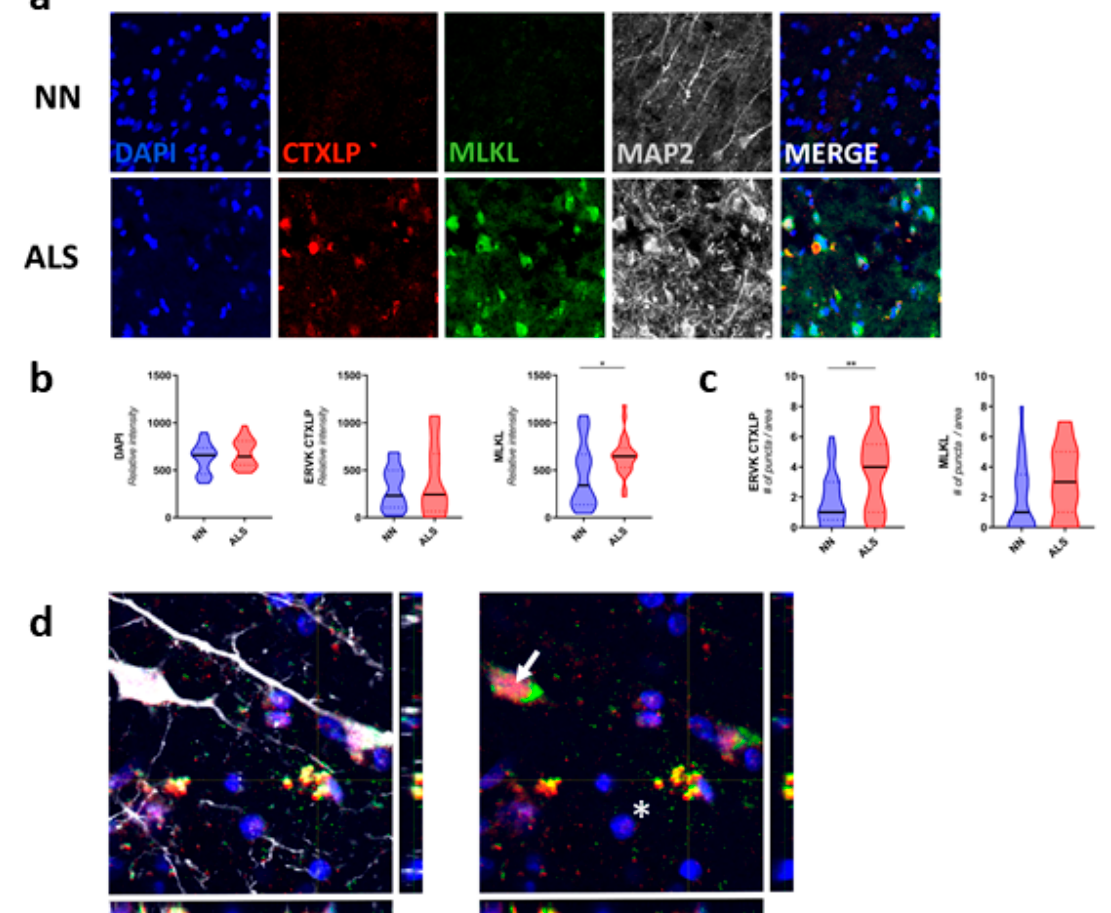
Figure 4. ERVK CTXLP is enhanced in the motor cortex of patients with Amyotrophic Lateral Sclerosis (ALS) and associated with necroptosis. ( a ) ERVK CTXLP levels are enhanced in motor cortex brain tissues of patients with ALS, as measured by confocal microscopy. Representative 40 × confocal micrographs of ERVK CTXLP (red), mixed lineage kinase domain-like (MLKL) protein (necroptosis marker, green) and neuronal microtubule-associated protein 2 (MAP2) expression (grey) in Brodmann area 6 (BA6, panel D) pre-motor cortex tissue of a neuro-normal (NN) control ( n = 5) and patient with ALS ( n = 5). DAPI stain depicts nuclei. ( b ) Violin plots of staining quantification of DAPI, CTXLP, and MLKL in NN and ALS cohorts for BA6 tissue. ( c ) Violin plots of protein puncta quantification of CTXLP and MLKL in NN and ALS cohorts for BA6 tissue). ( d ) Enhanced expression of MLKL in CTXLP + neurons from the motor cortex of a patient with ALS (arrow). The nearby degenerating cell is marked with co-localized CTXLP + MLKL + puncta (asterisk). Statistical test with unpaired two-tailed t-tests, (* p < 0.05 ** p < 0.01, black bars are medians).